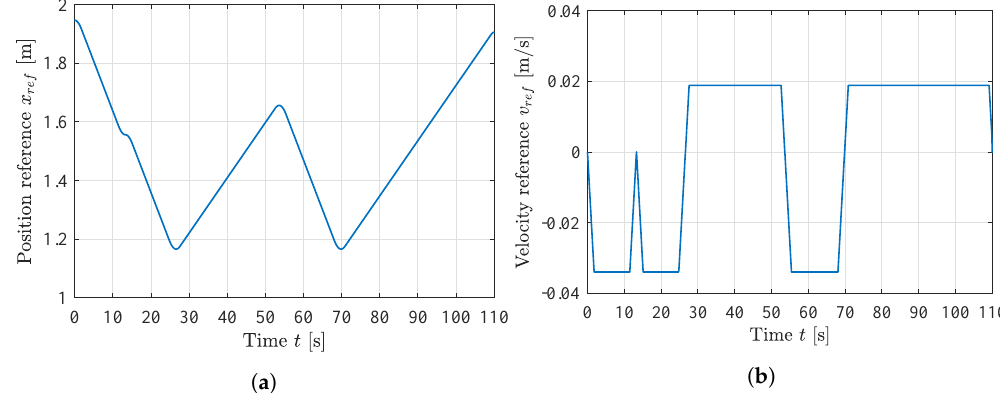
Figure 15. Point-to-point path references for simulation. ( a ) Position reference; ( b ) Velocity reference.